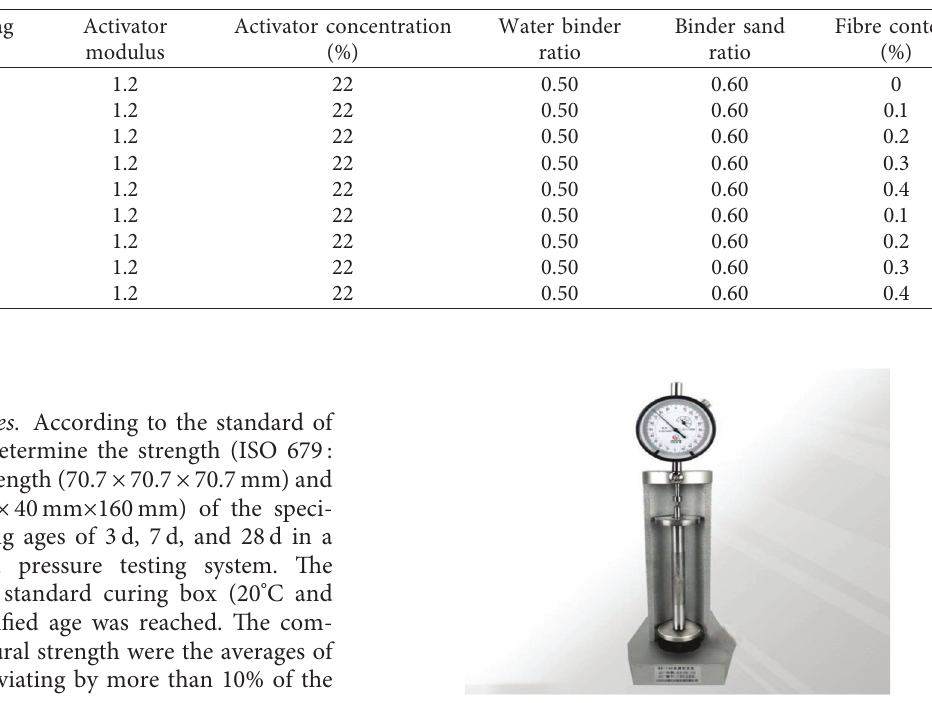
Table 3: Mix proportions of geopolymer